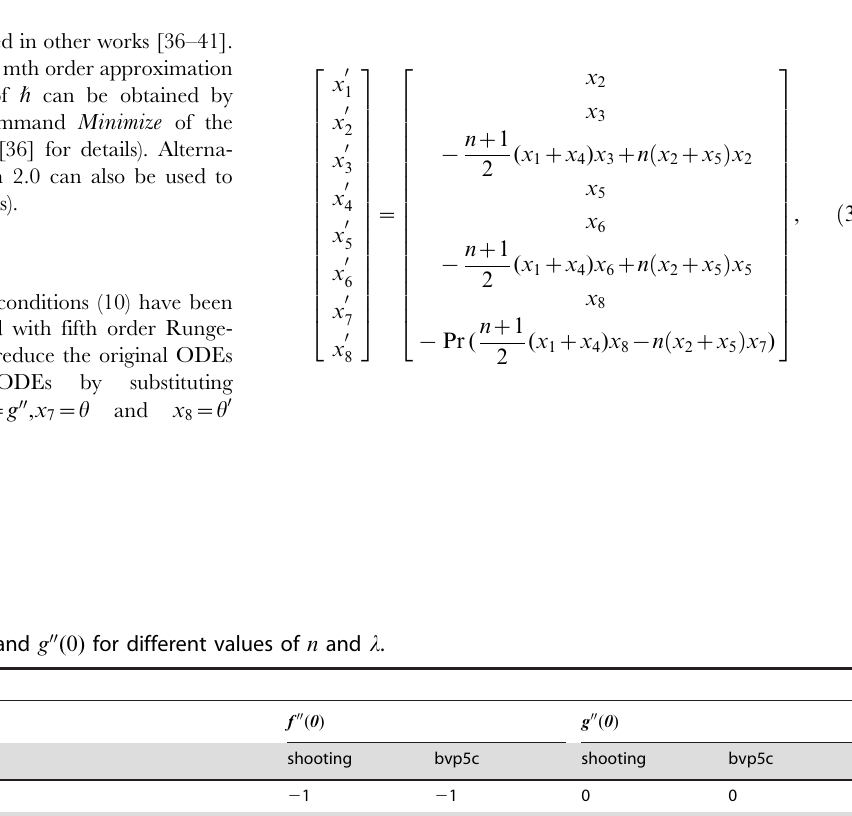
Figure 8. Influence of Prandtl number Pr and stretching rates ratio l on the wall temperature gradient h 0 (0) :